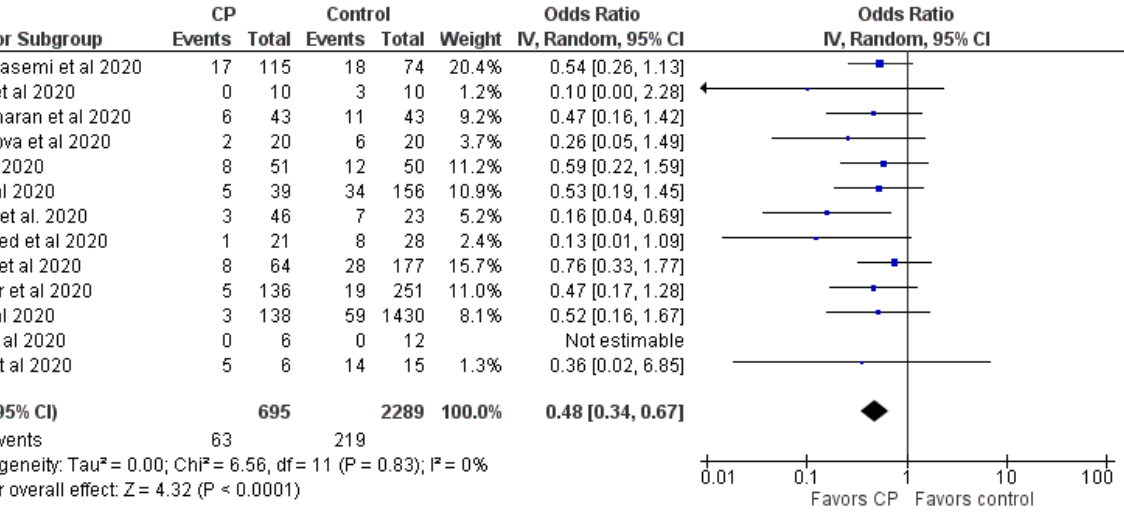
Figure 2. Efficacy of CP treatment on mortality in COVID-19 patients. Data from 13 controlled clinical trials were pooled using an inverse variance method and analyzed using a random-effects model. Odds ratios and 95% CIs were used as statistical measures for mortality as a dichotomous outcome. CP: convalescent plasma.